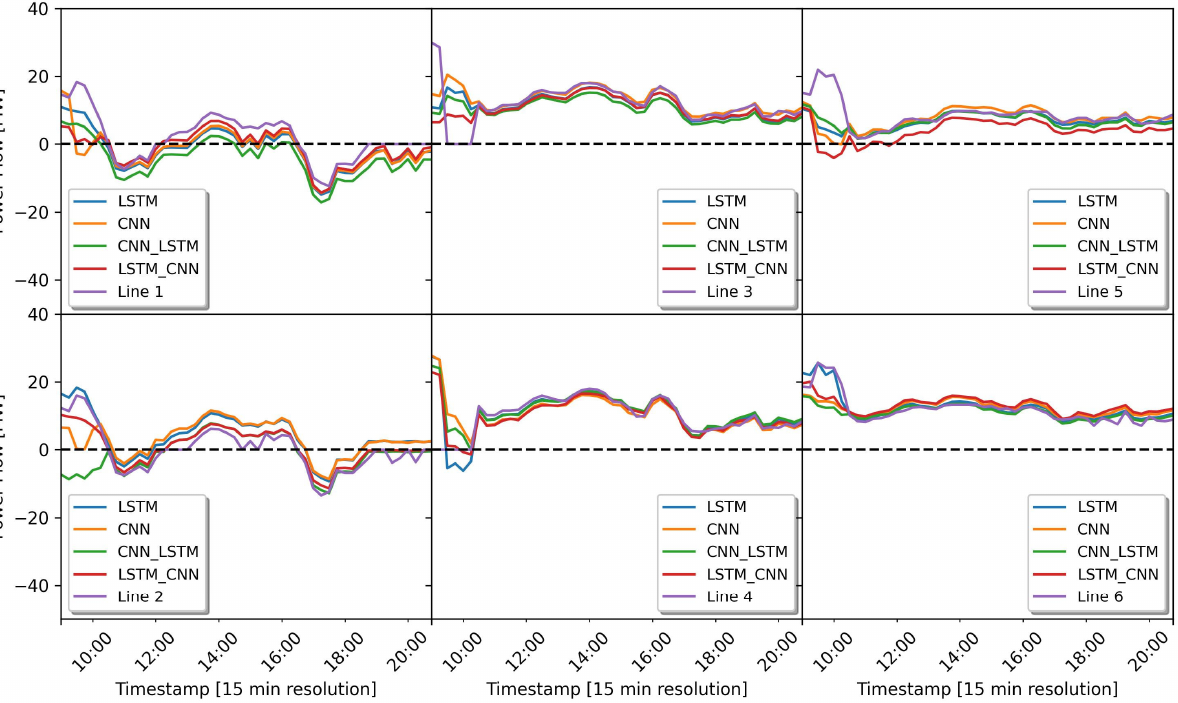
Figure 14. Prediction results of the power flow direction based on real power measurement and weather data.